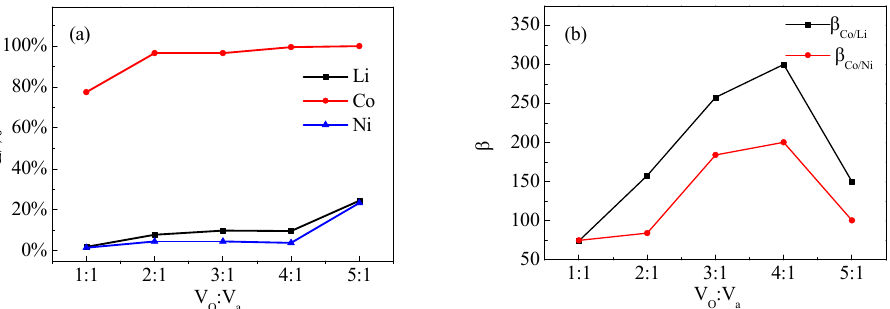
Figure 10. Effect of V o :V a on ( a ) extraction efficiency and ( b ) separation coefficient (V P507–N235 : V kerosene = 1:3, V P507 :V N235 = 3:7, pH = 2.5).